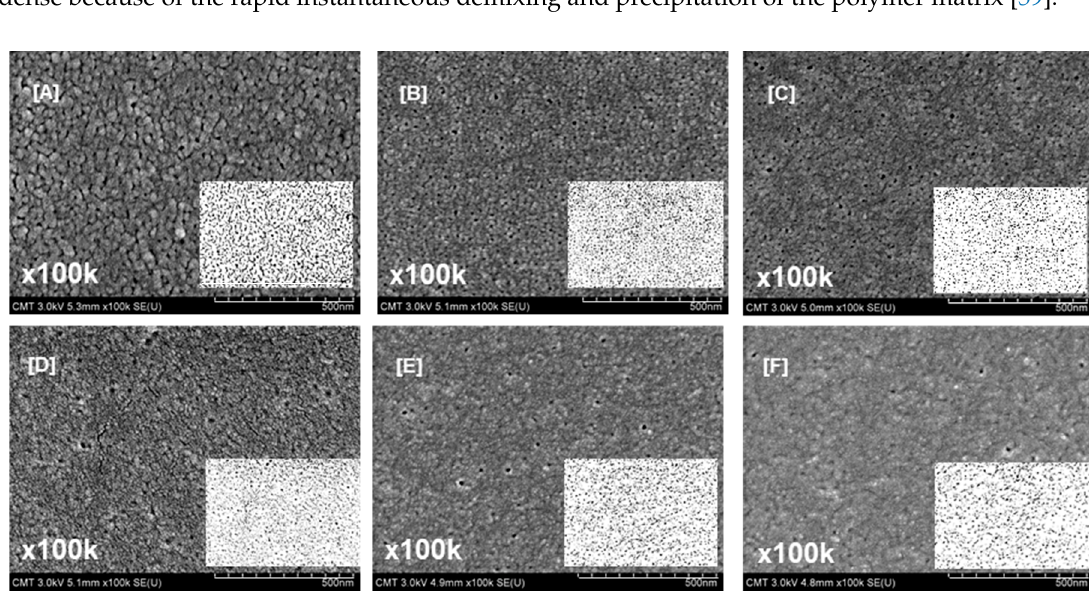
Figure 2. Surface images of PSf supports modified using PEG of varying molecular weights: ( A ) 0; ( B ) 200; ( C ) 1000; ( D ) 10,000; ( E ) 20,000; and ( F ) 35,000. Insets are ImageJ photos for quantifying the surface porosity. Magnification, 100k × ; Scale bar, 500 nm.